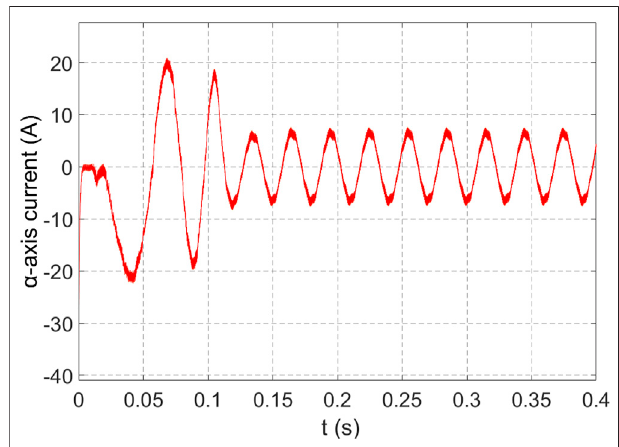
FIGURE 3 | Rotor position.